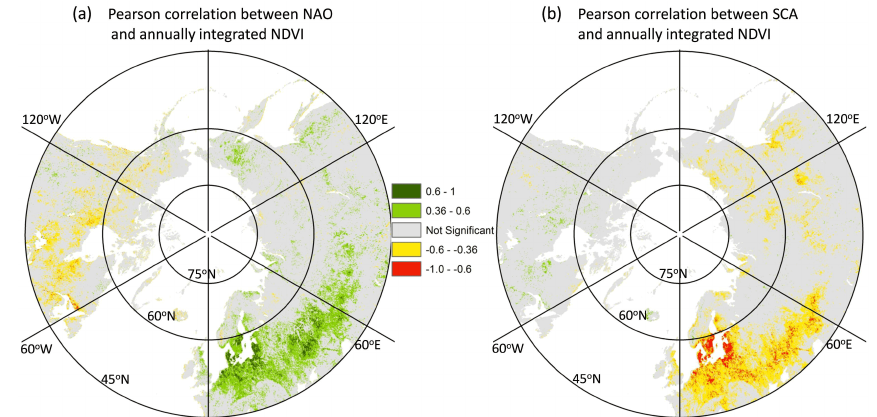
Figure 4. Relationships (values in Pearson correlation coefficient) between the growing season annually integrated normalized difference vegetation index (NDVI) and the North Atlantic Oscillation (NAO) (a) , and the Scandinavia Pattern (SCA) (b) . Both teleconnection and NDVI data sets were detrended. All colour shaded values are significant at 95% confidence level from a two tailed Student’s t test.